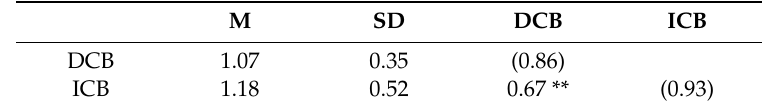
Table 3. Descriptive statistics, factor correlations, and Cronbach’s alpha (in parentheses) for the two-factor model.